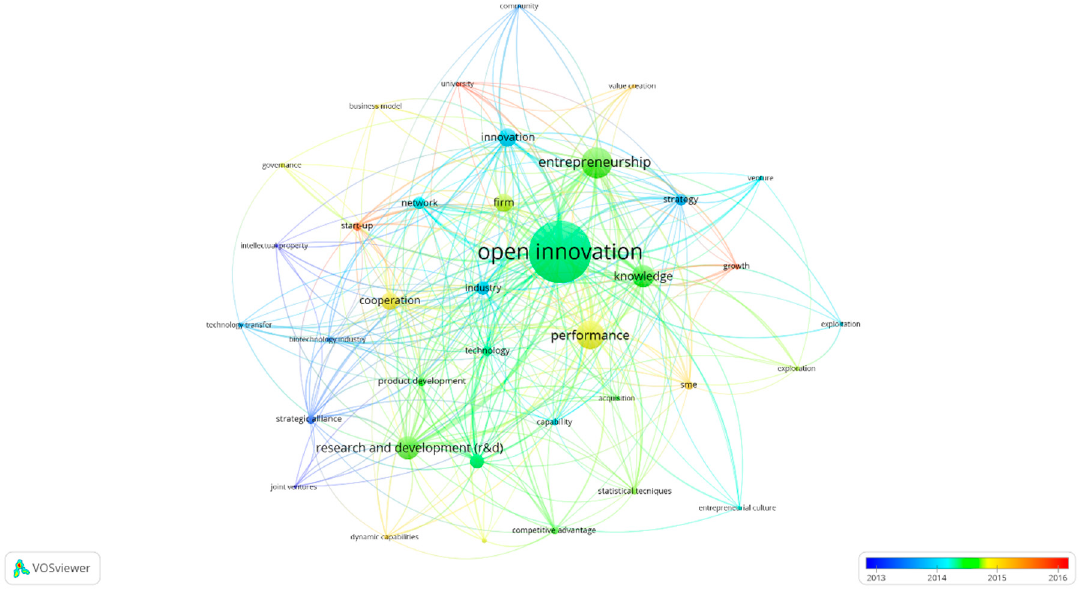
Figure 6. Evolution over time of topics.